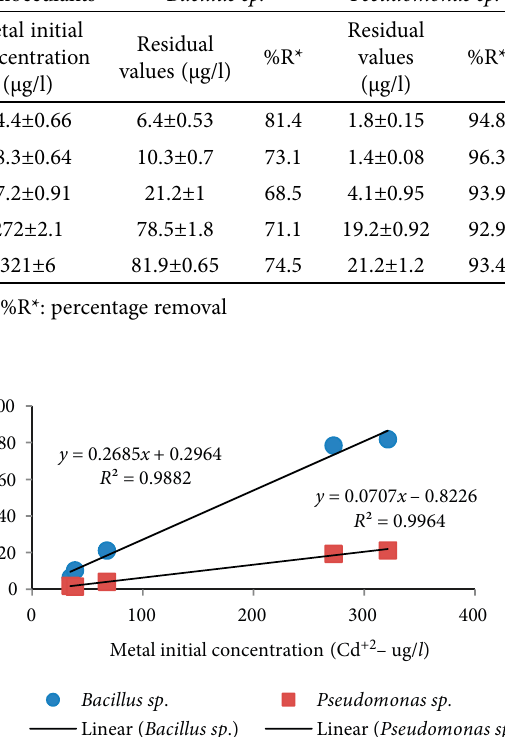
Fig. 3. Relationship between the initial concentration and residual values of Cadmium (Cd 2+ ).